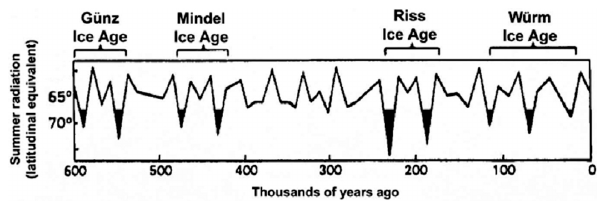
Figure 2. Milankovitch’s curve of insolation (slightly edited for better